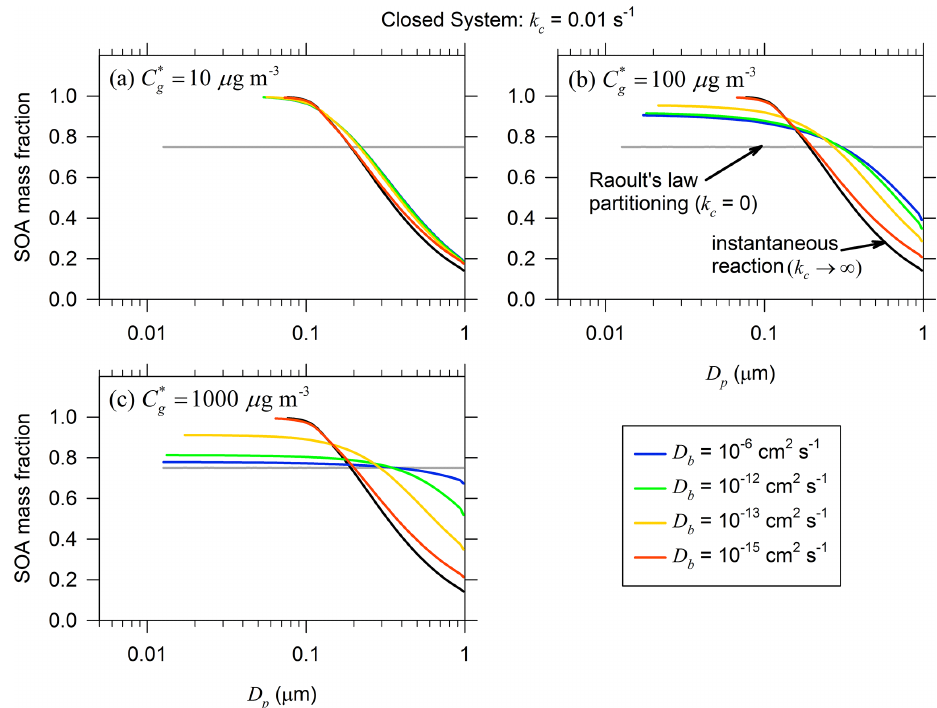
Figure 17. Final size distributions of the newly formed SOA mass fraction for different D b values and (a) C ∗ g = 10µgm − 3 , (b) C ∗ g = 100µgm − 3 , and (c) C ∗ g = 1000µgm − 3 . Each panel also shows the reference plots for instantaneous reaction (black line; k c → ∞ ) and for Raoult’s law partitioning (gray line; k c = 0s − 1 ) for any D b and C ∗ g >